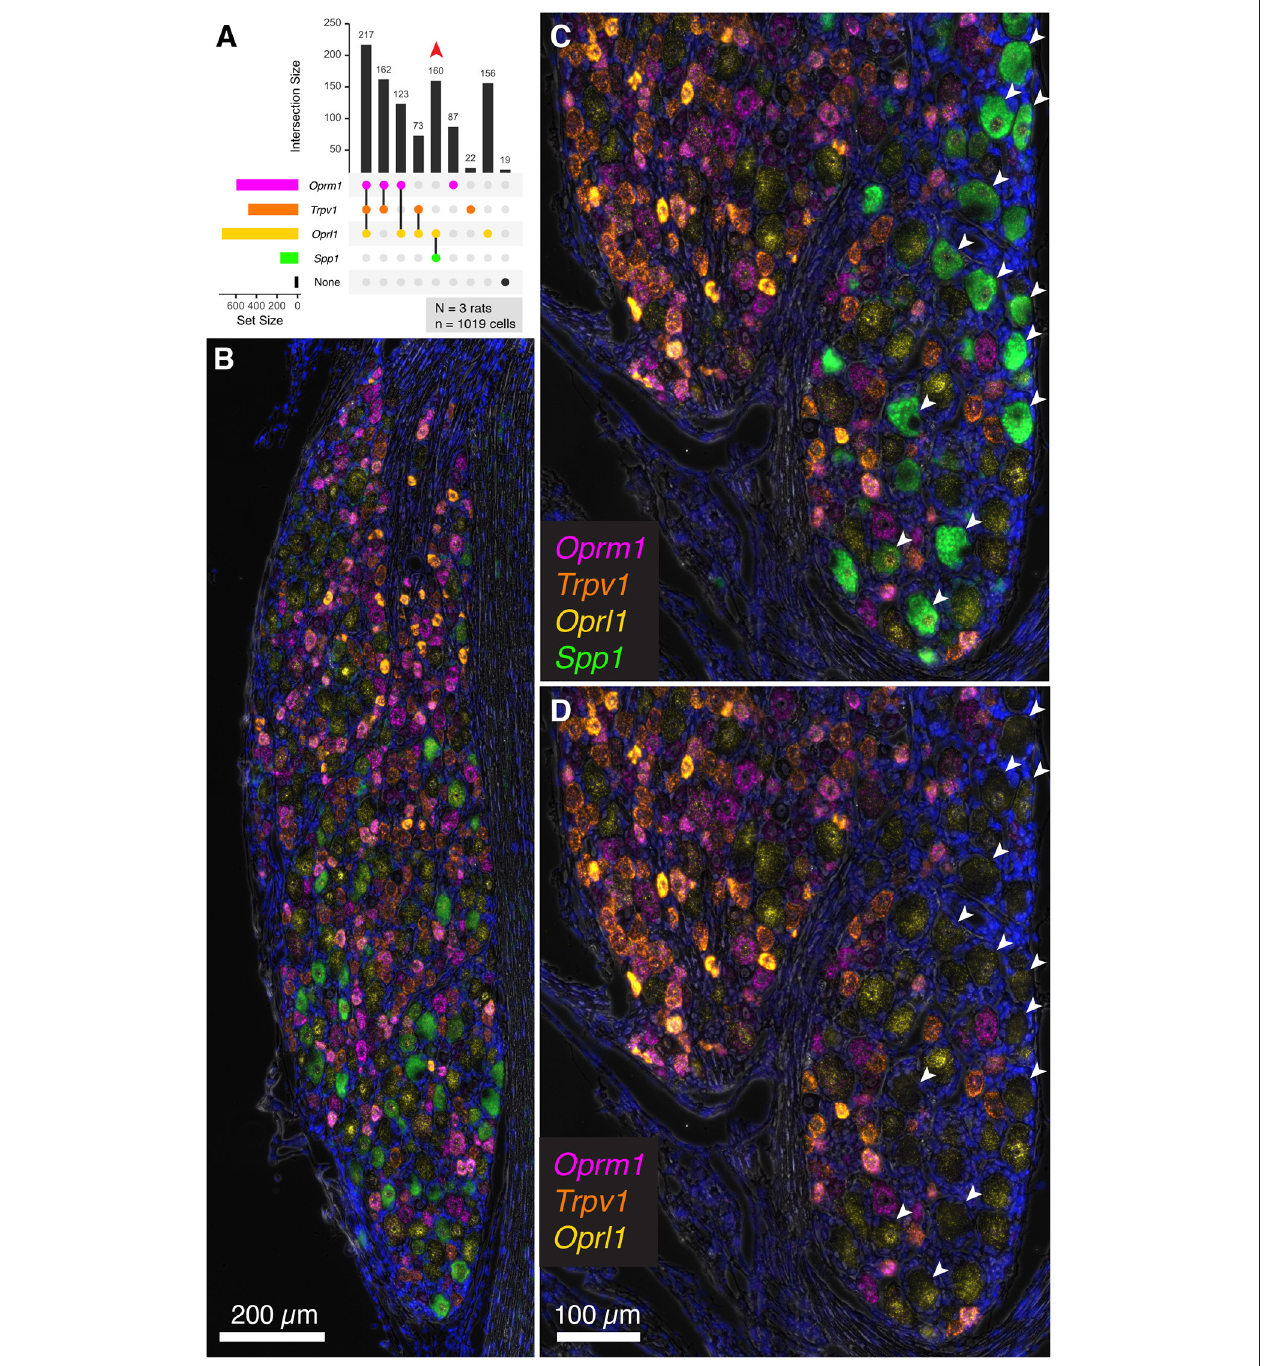
FIGURE 8 | Co-expression of the nociceptive and analgesic markers Trpv1 , Oprm1 , and Oprl1 with Secreted Phosphoprotein 1/Osteopontin ( Spp1 ) transcript. Co-expression of Trpv1 , Oprm1 , and Oprl1 with Spp1 , a marker of DRG neurons thought to be chiefly implicated in proprioception. (A) In a co-expression plot, all of the Spp1 neurons co-expressed Oprl1 , while none showed expression of Trpv1 or Oprm1 (83 Spp1 / Oprl1 neurons, red arrow). (B) A panoramic view of a whole + + + rat DRG stained for this combination of markers. Note the distinct signal for Spp1 . (C) An enlargement of a different DRG neuron shows spatially distinct areas with and without Spp1 neurons. (D) Note that Spp1 neurons (arrows) do not contain any Trpv1 or Oprm1 signal. + of Trpv1 is similar to previous studies, although it appears that the RNAScope procedure, in particular, labels more neurons than most antibody-based approaches (Mitchell et al., 2010,